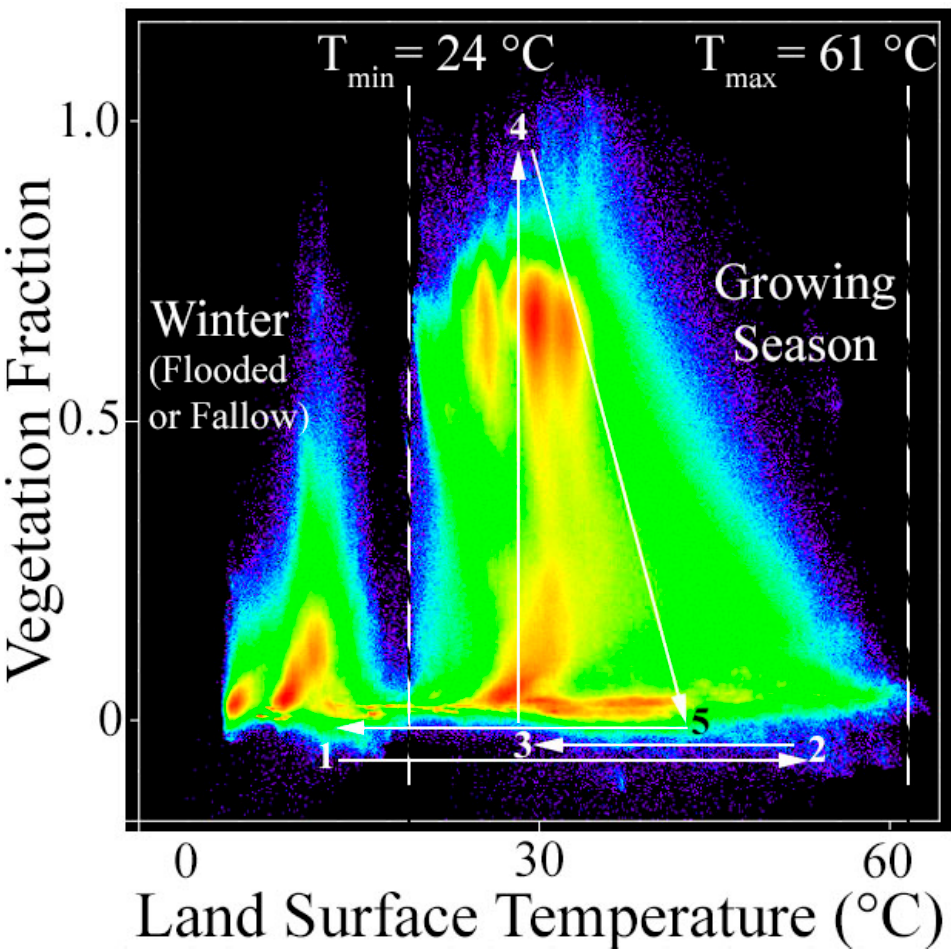
Figure 9. Relationship between vegetation and soil LST throughout the study period. A clear gap is present between the soils during the summer growing season (higher LST) and winter fallow season (lower LST). Physical bounds to growing season temperatures are easily recognizable, yielding straightforward values for T min and T max as defined by Carlson et al., 1994. Schematic rice phenological trajectory shown with white arrows. Rice fields are unvegetated and cold in winter (1). In spring, the fields are drained and leveled, remaining unvegetated and sometimes reaching high temperatures due to the low heat capacity of dry soil. Fields are then flooded and planted (3), after which point the rice plants begin to grow until maturity (4). In late summer and early fall, plants senesce and then are harvested in mid-to-late fall (5). After harvest, many rice fields are then flooded again, returning them to their winter state (1).